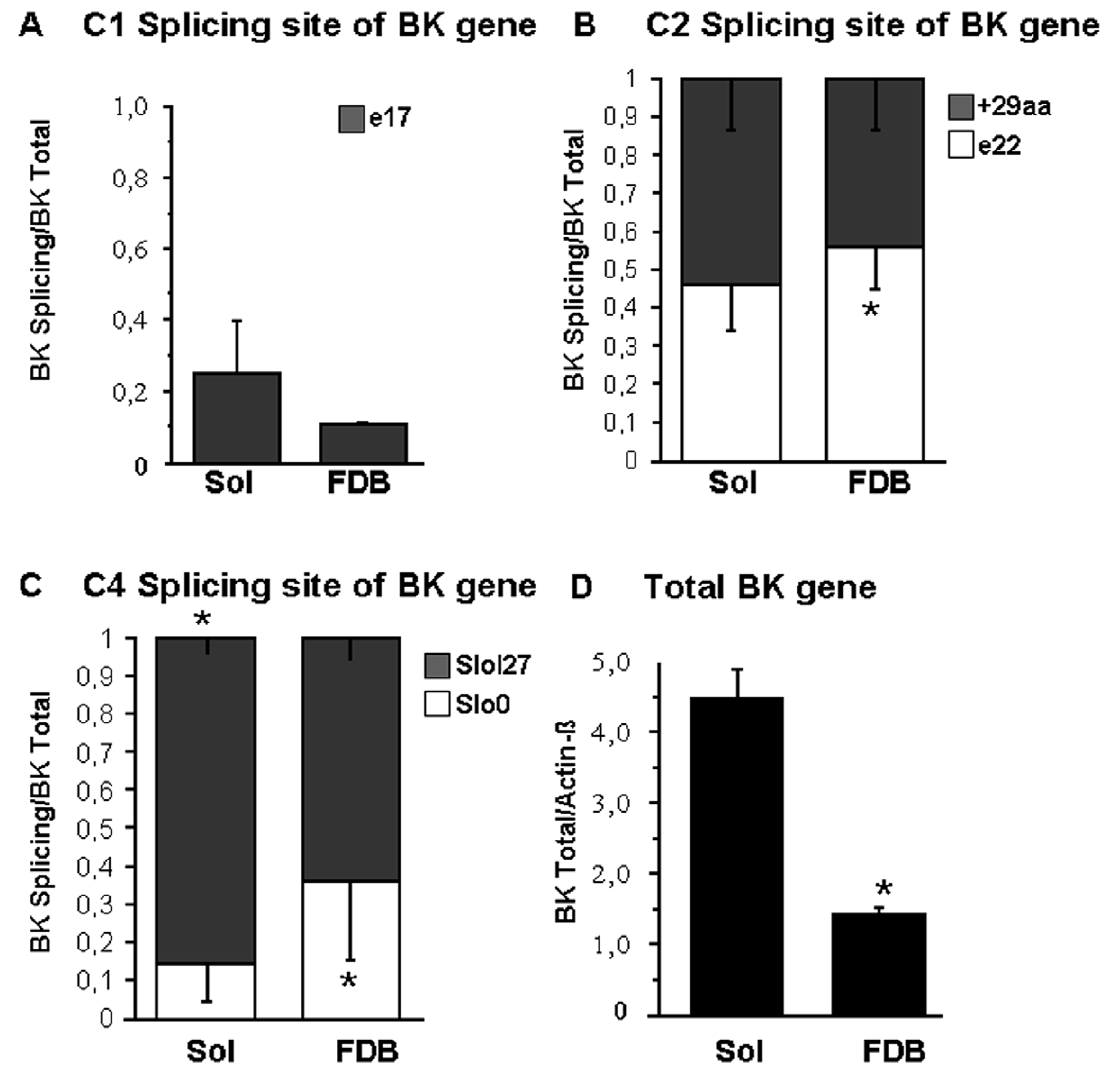
Figure 2. Differential tissue distribution of BK channel splice variant mRNA. mRNA levels of C1 (A), C2 (B) and C4 (C) splice variants in Sol and FDB expressed as a fraction of total BK channel mRNA expression in each tissue. (D) Differential tissue distribution of total BK channels. mRNA expression of total BK channels is normalized to the expression of beta -actin. Significant differences between data are evaluated by the unpaired Student’s t-test at p , 0.05.